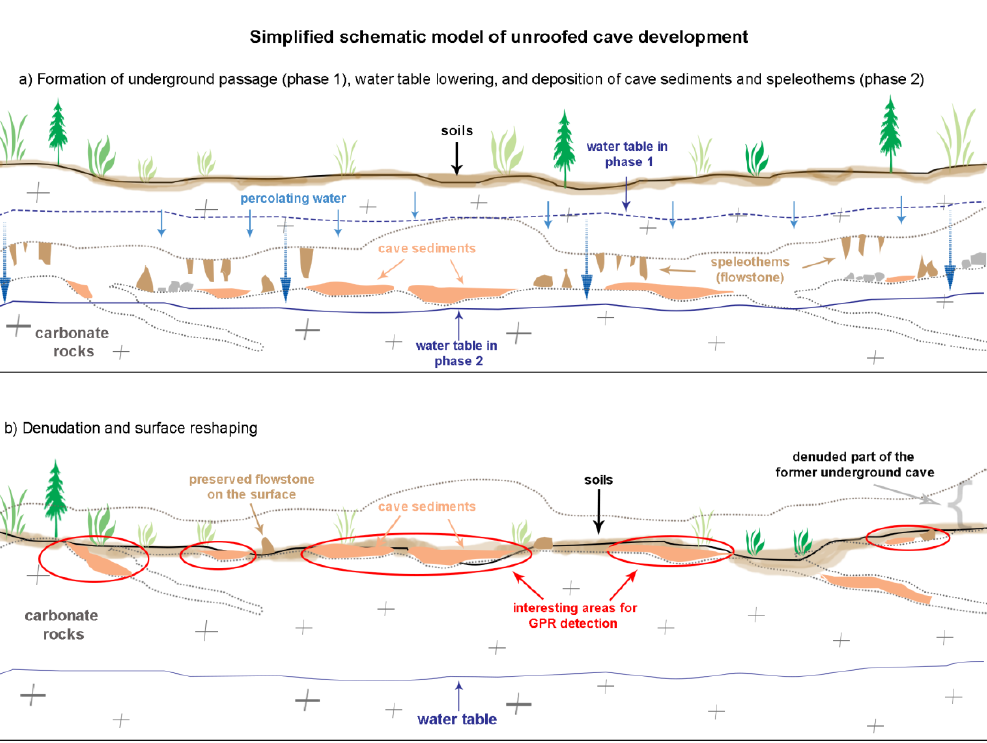
Figure 3. Indirect indicators for the possible presence of cave sediments: ( a ) Cave sediments are sometimes associated with surface deepening, so the road must be frequently filled to keep it passable; ( b ) Increased water retention in sediments even during dry periods is evident in certain places. In the area below the increased water retention septarian concretions were found as one of the most reliable indicators of speleogenesis.